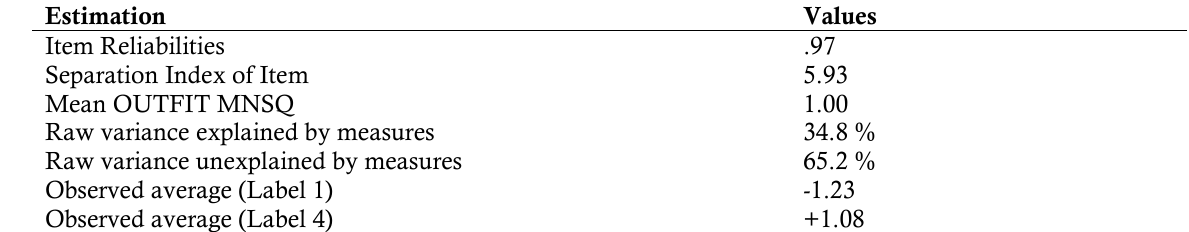
Table 1. Summary of quality test items